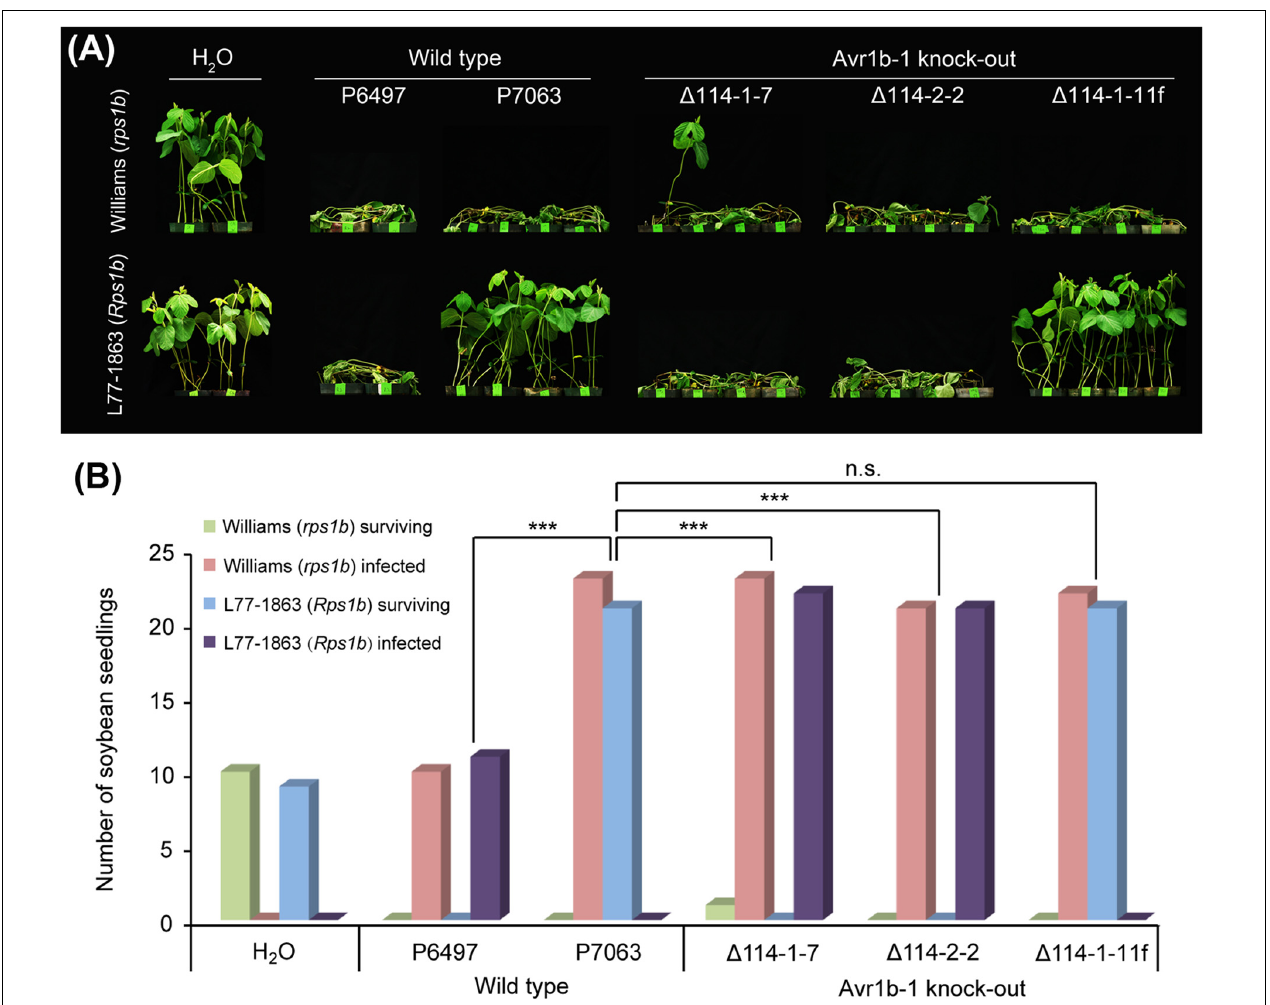
FIGURE 1 | Avirulence phenotypes of Avr1b-1 knock-out transformants measured by hypocotyl inoculations. (A) Avr1b-1 -silenced wild-type isolate P6497, Avr1b-1- expressing wild-type isolate P7063, and two homozygous Avr1b-1 deletion transformants (cid:49) 114-1-7 and (cid:49) 114-2-2, plus a non-replacement transformant (cid:49) 114-1-11f were inoculated onto the hypocotyls of 7 day-old seedlings of soybean cultivar Williams ( rps1b ) or L77-1863 ( Rps1b ). Pictures were taken 3 days after wound inoculation. (B) Numbers of infected and surviving seedlings after inoculation with the P. sojae strains. A strain was deemed to be avirulent if the number of inoculated Rps1b seedlings surviving was significantly higher than the number of surviving seedlings without the Rps1b gene, and the number was not significantly different from the number of surviving seedlings inoculated with wild-type P7063. At least eight seedlings were used for the inoculation of each control or transformant. The significance of differences was determined by Fisher’s exact test ( P < 0.001). *** = significant; n.s. = not